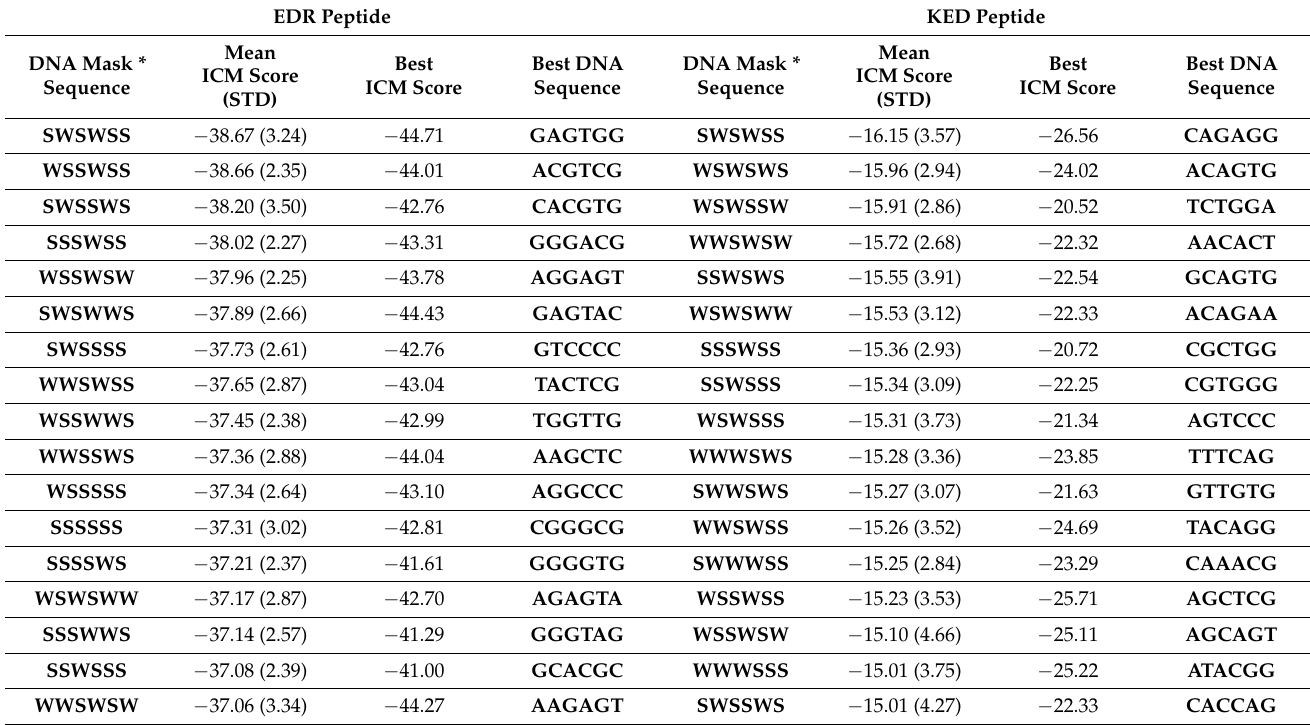
Table 1. Distribution of ICM scores in the peptide—hexanucleotide complexes having the same DNA mask * sequence. EDR Peptide KED Peptide DNA Mask *